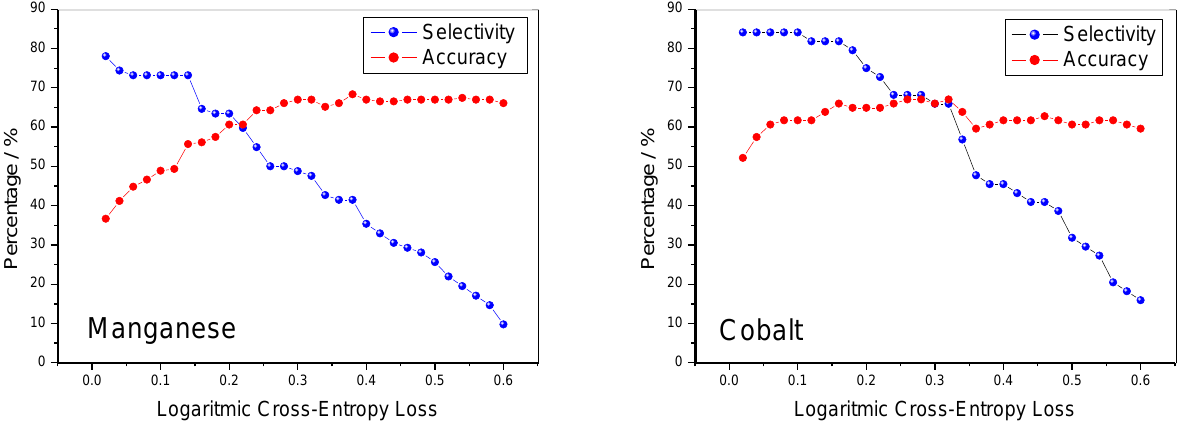
Figure 6. Selectivity and accuracy as a function of LCEL value for lithiated manganese ( left ) and cobalt ( right ) oxides.